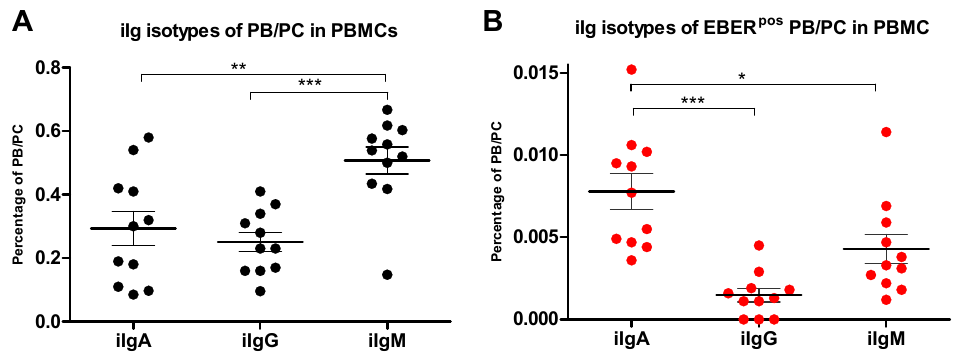
Fig. 3. EBER pos PB/PC cells are predominantly of iIgA +